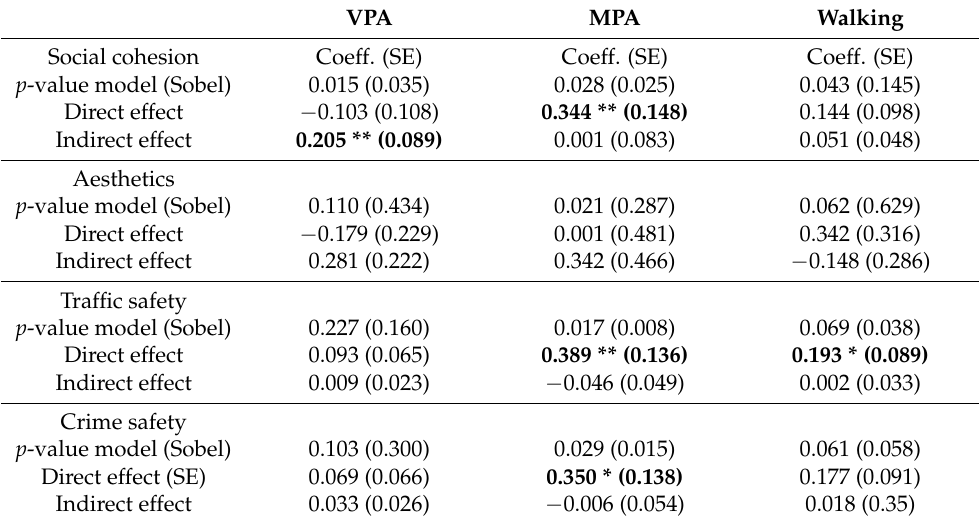
Table 3. Direct, indirect, and total effects of the mediation